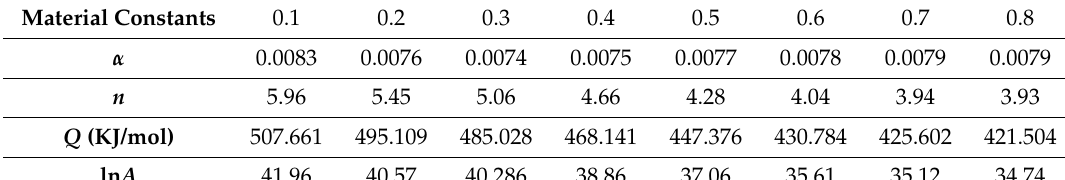
Table 1. Constitutive equation parameters under different true strains.